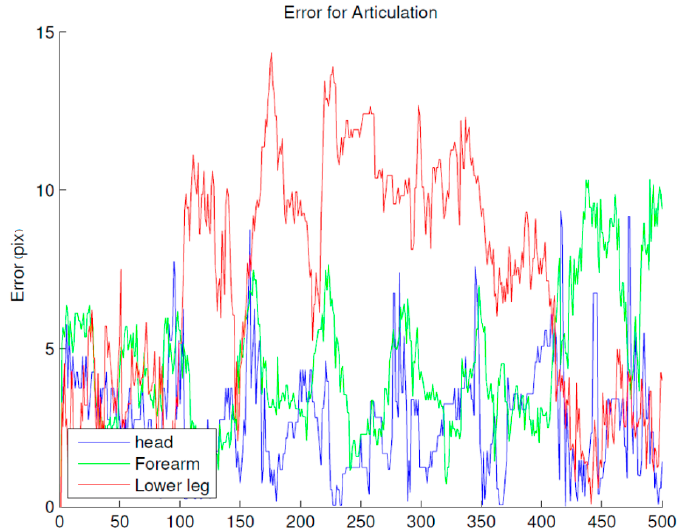
Figure 9. Tracking errors of the body extremities. Placing the omnidirectional camera at a height of 1.5 m allows the person’s head to be visible in all images, which facilitates its tracking and explains the good obtained accuracy.